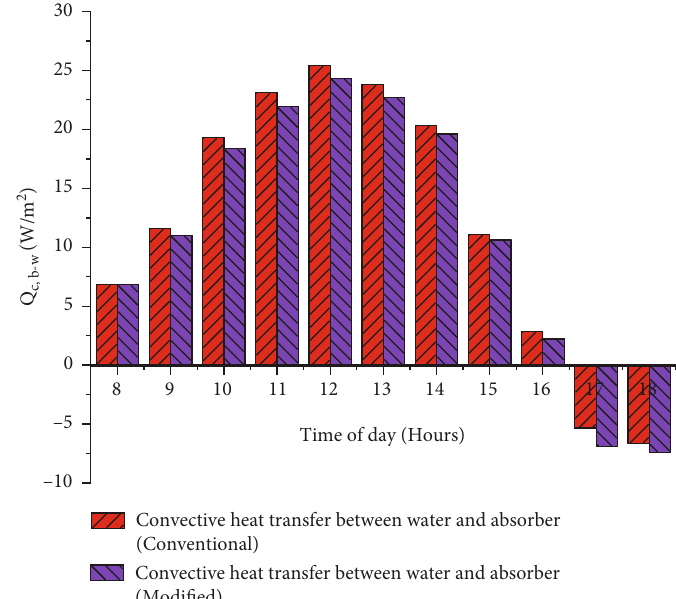
Figure 5: Variations in CHTC between water and basin of CBSS and TBSS. Table 2: Comparison of yield and thermal e ffi ciency from the CBSS and TBSS. Date of